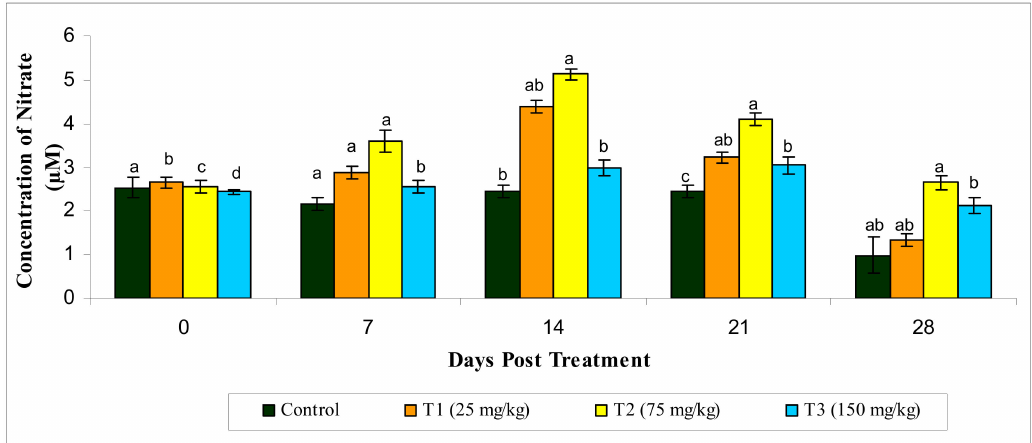
Figure 7. E ff ect of methanol extract of Chaetomorpha antennina on the Reactive Nitrogen Species production by peripheral blood leukocytes in Labeo rohita (values are mean ± SE). a,b,c,d Mean values with di ff erent superscripts considered as statistically di ff erent ( p < 0.05); n = 6 for each treatment